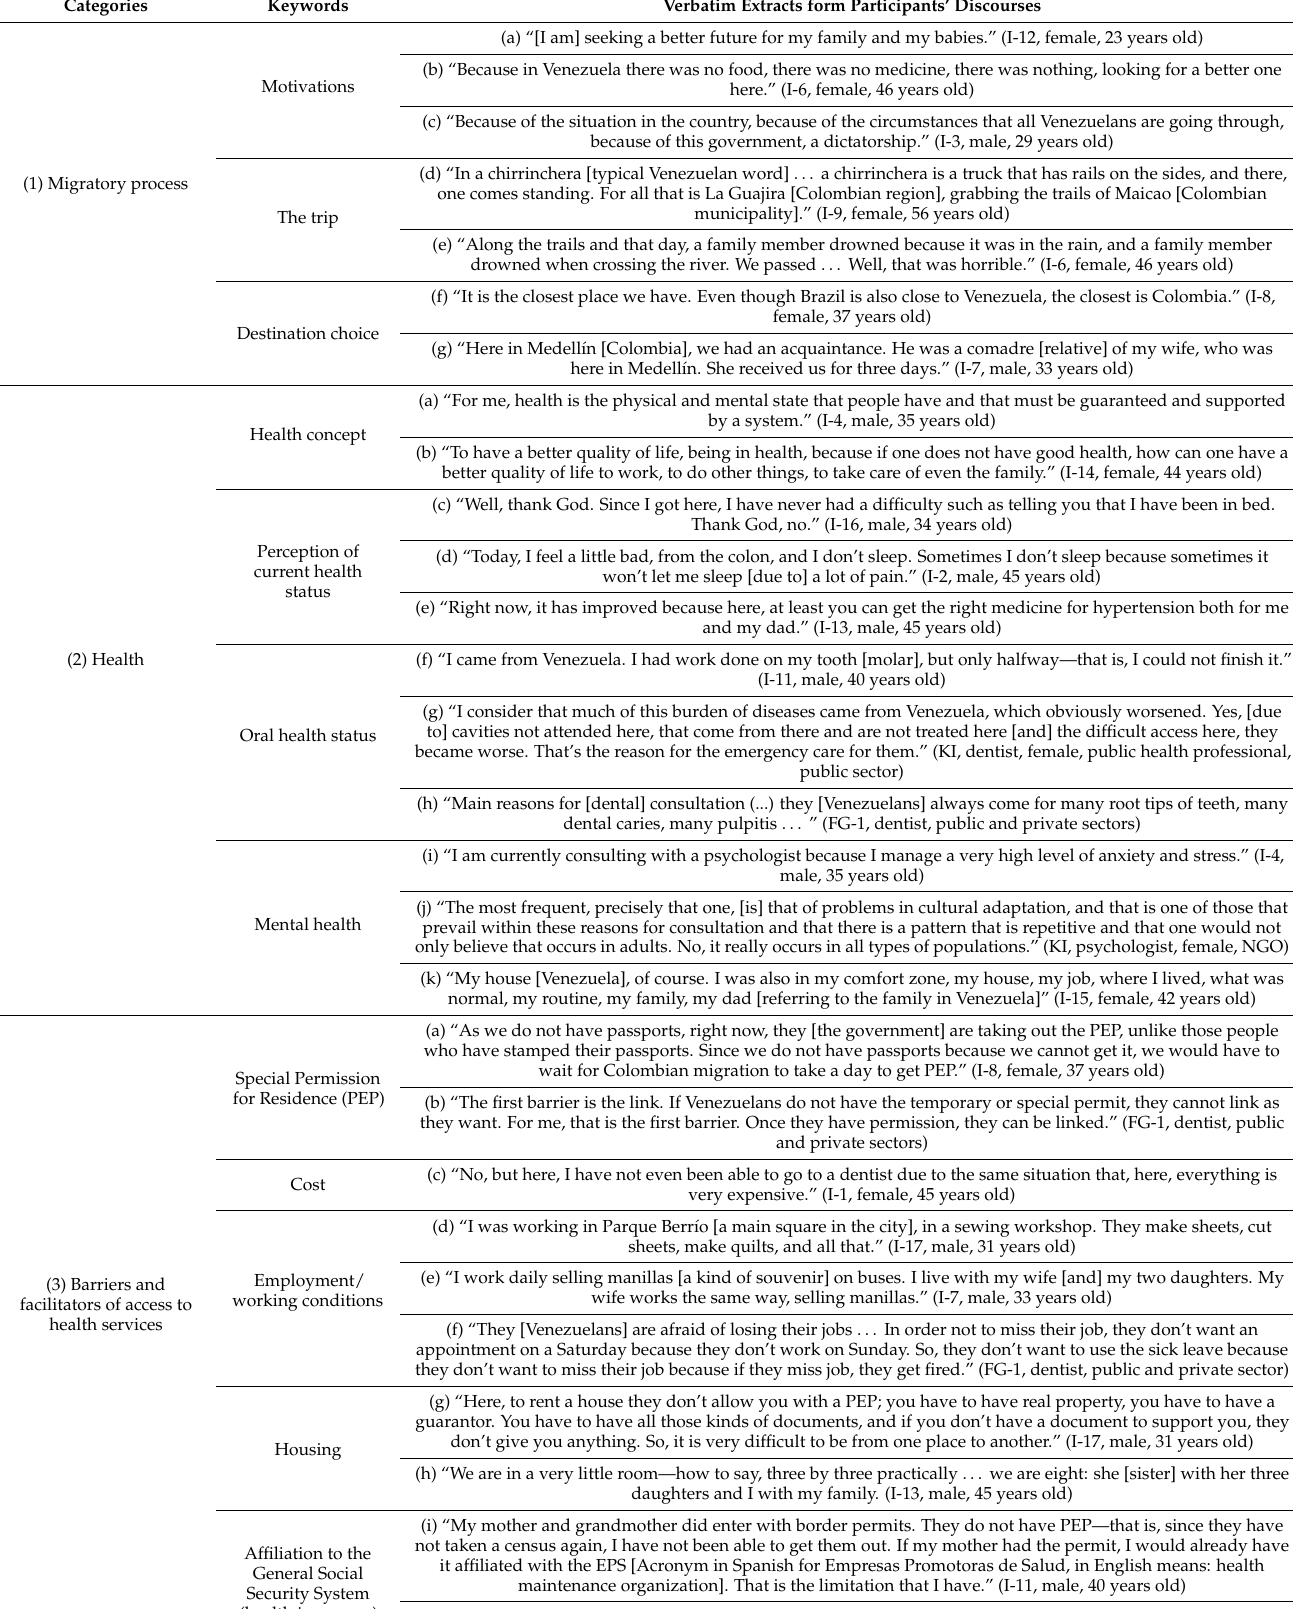
Table 2. Verbatim interview extracts from participants’ discourses. Medell í n, Colombia (2020)